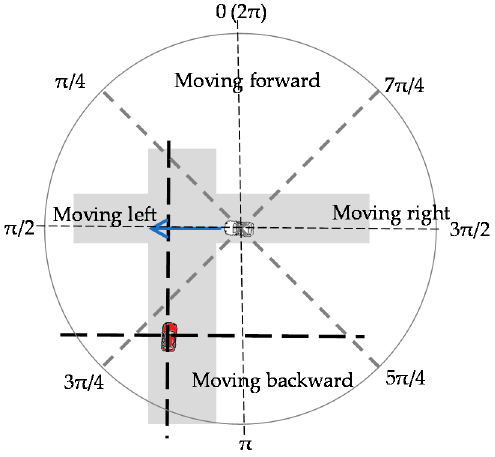
Figure 3. Determining the relative direction of the communicating vehicle. The red vehicle is the own vehicle.